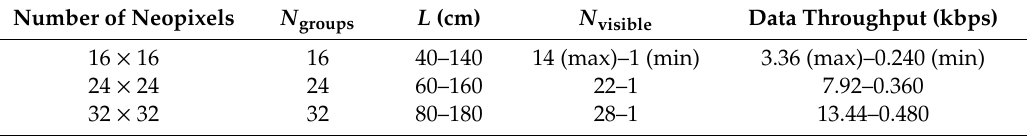
Table 3. Theoretical (approximation) data throughput based on di ff erent Tx configurations.